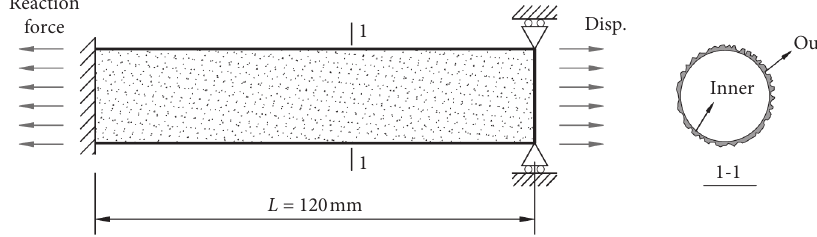
Figure 1: Pipe specimen under uniaxial stretch